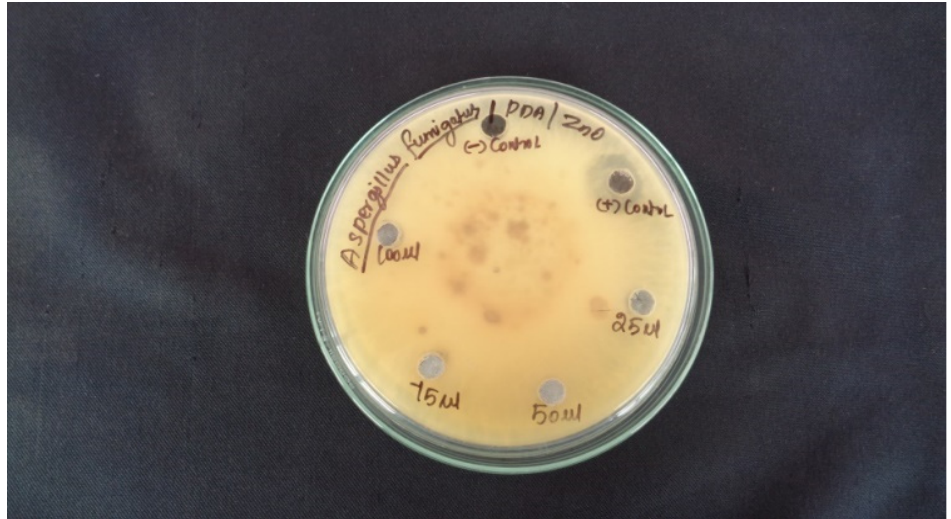
Figure 7. Antibacterial activity of ZnO Nps and Leaf extract.